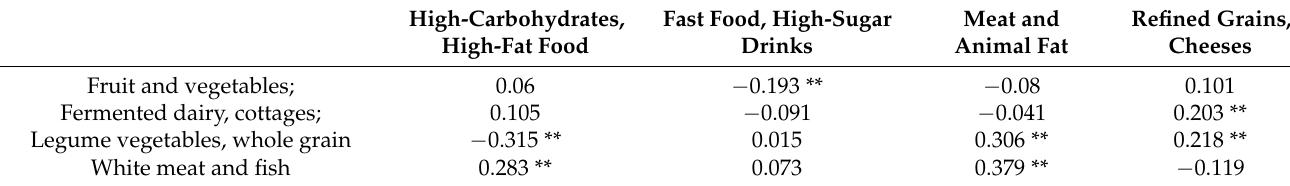
High-Carbohydrates, Fast Food, High-Sugar Meat and Refined Grains, High-Fat Food Drinks Animal Fat Cheeses